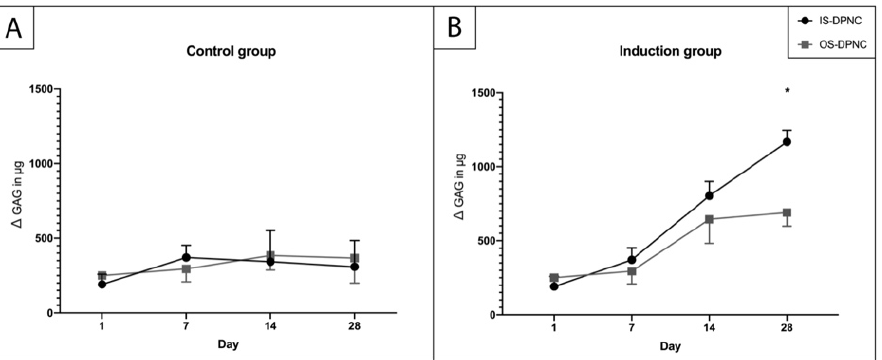
Figure 4. Quantification of sGAGs using DMMB assay. No increase in sGAG production occurred in control group ( A ) during the culture period. ( B ) A significantly higher ( p = 0.0105) sGAG concentration was measured on IS compared to OS after 28 days of in vitro culture (n = 3; * p < 0.05; mean ± SD).